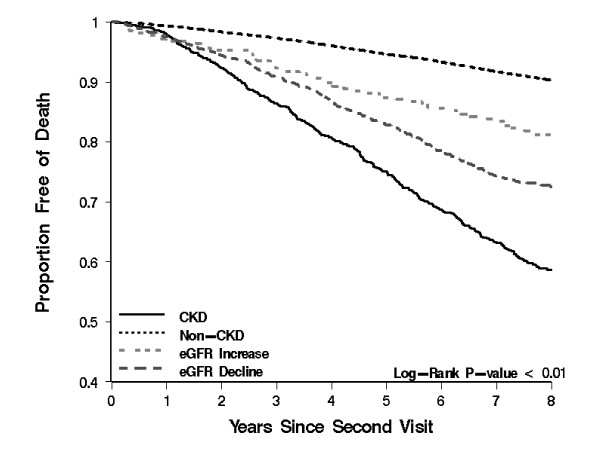
Kaplan-Meier curves presenting the relationship between kidney function groups and Mortality outcomes.